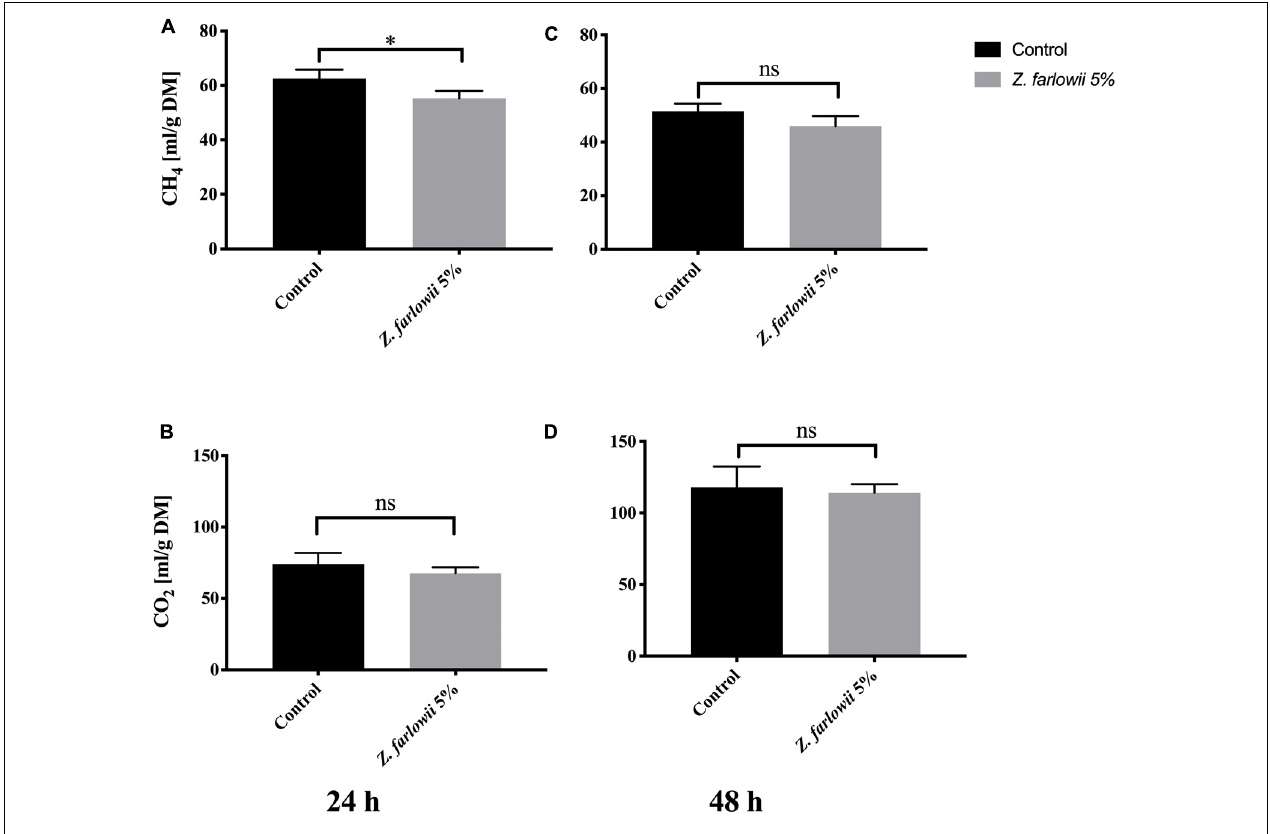
FIGURE 4 | Methane and CO 2 production during in vitro fermentation of rumen fluid amended with Z. farlowii . Production of CH 4 mL (g DM) − 1 and CO 2 mL (g DM) − 1 from vessels without ( n = 3) and with 5% ( n = 3) Z. farlowii as additive. Methane and CO 2 were measured at 24 h ( A,B , respectively) and 48 h ( C,D , respectively). “ ∗ ” indicates significant difference ( p -value < 0.05), “ns” indicates not significant. Error bars represent the standard error from the